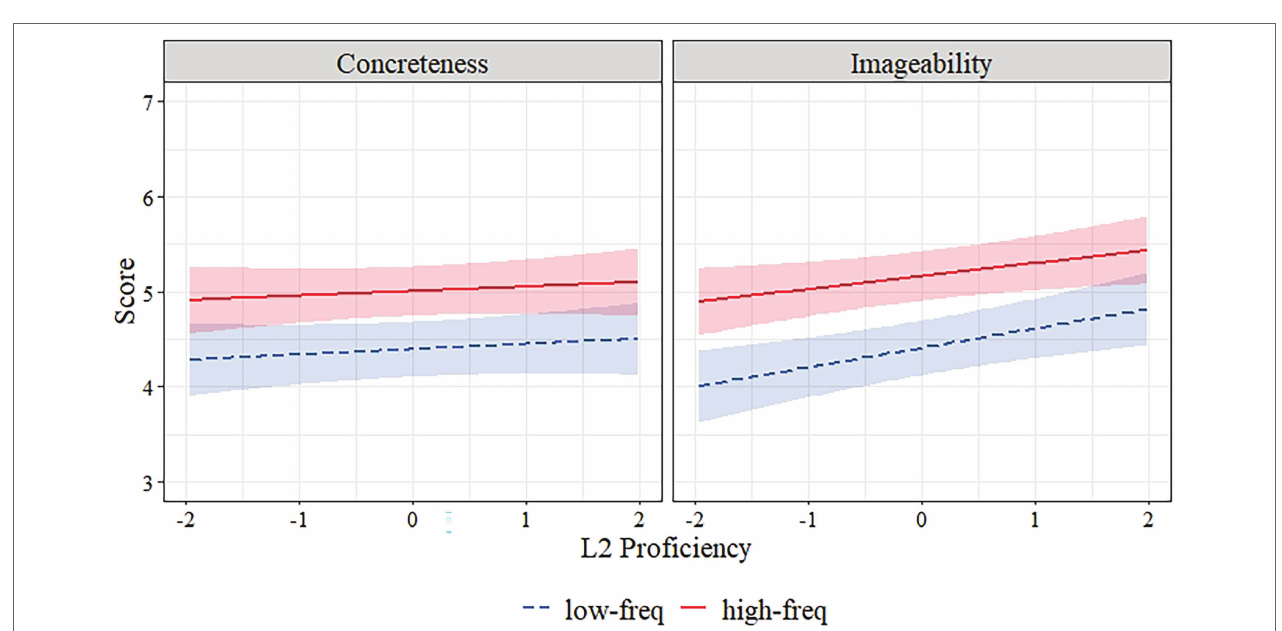
FIGURE 1 | The relationship between L2 proficiency and scaled scores of concreteness, imageability ratings of hi-lo frequency words. The hues around regression lines represent 95% confidence